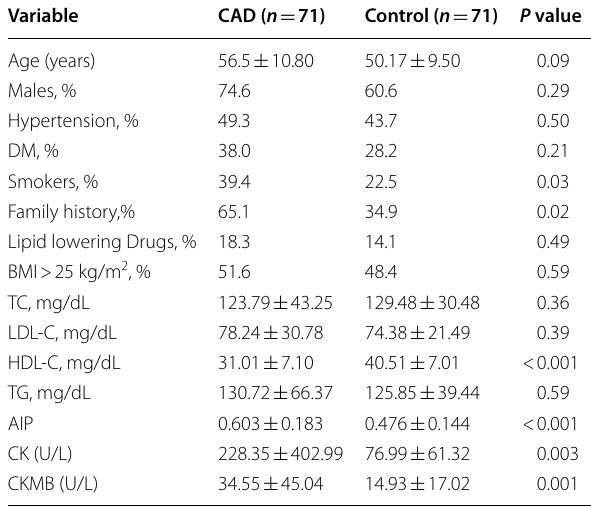
Table 1 Demographic, clinical, and biochemical characteristics of the study population